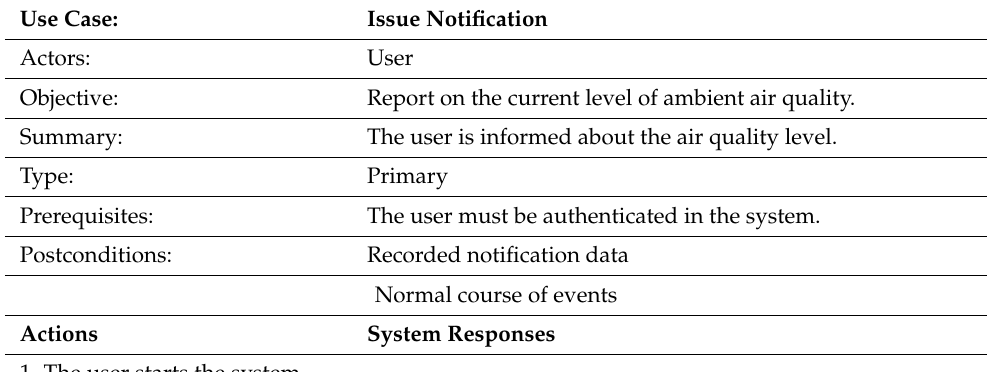
Table 5. Specification of the use case for issuing